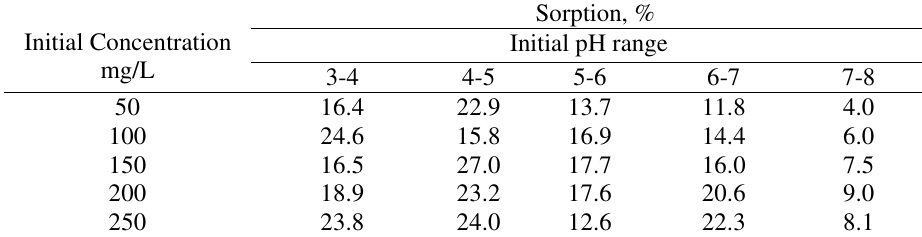
Table 4. Sorption (%) between pH Ranges at different initial